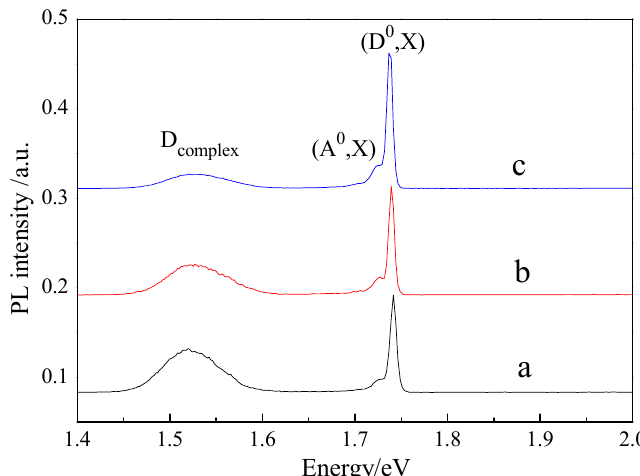
Figure 9. PL spectra of CMT:In crystals after multi-step annealing: (a) Cd atmosphere annealing at 873 K and Te annealing re-annealing at 773 K; (b) Cd atmosphere annealing at 973 K and Te annealing re-annealing at 773 K; (c) Cd atmosphere annealing at 1073 K and Te annealing re-annealing at 773 K.